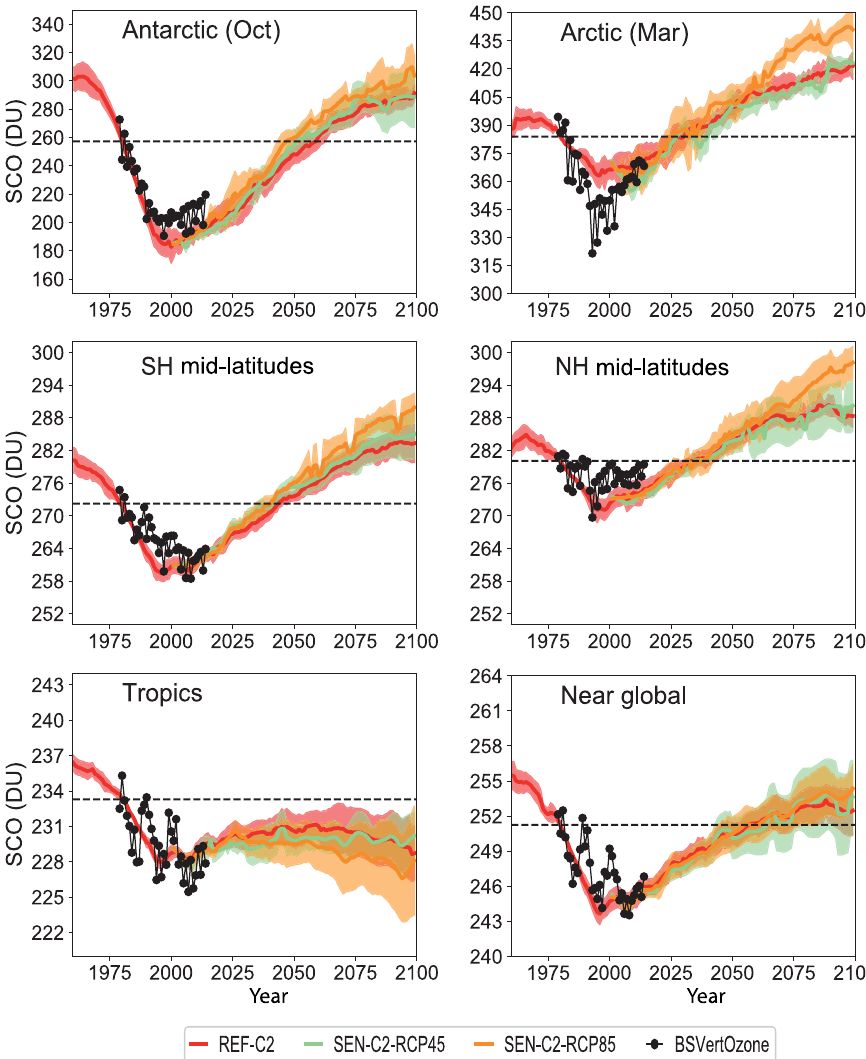
Figure 11. As Fig. 10 but for stratospheric column ozone